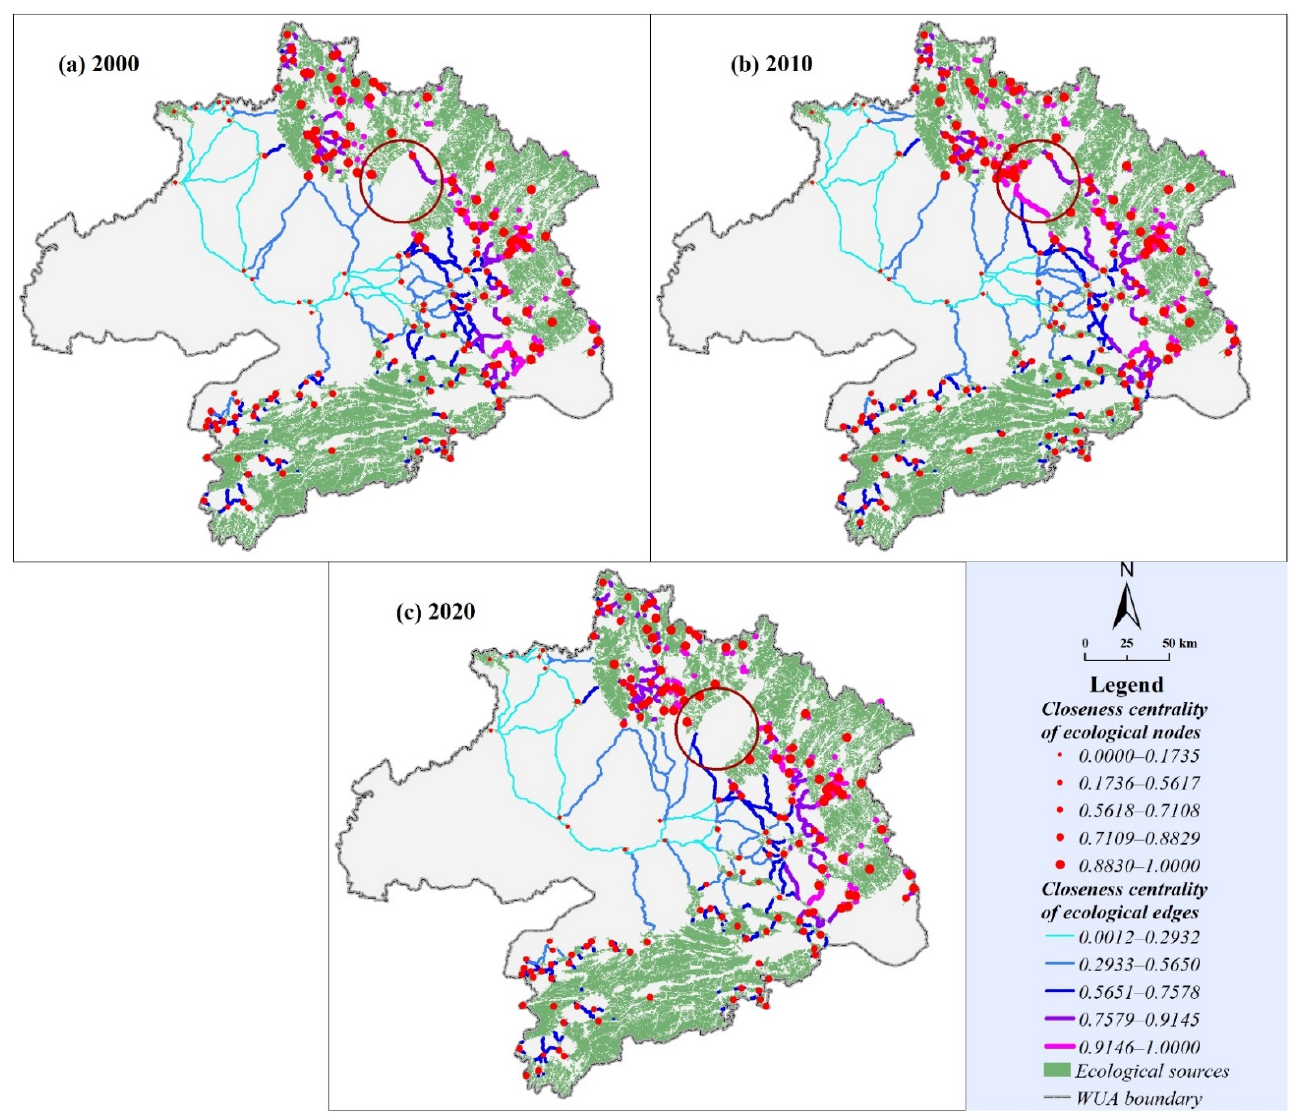
Figure 9. Spatial distribution of closeness centrality in 2000, 2010, and 2020. Table 3. Composition of land use types for ecological barriers in 2000, 2010, and